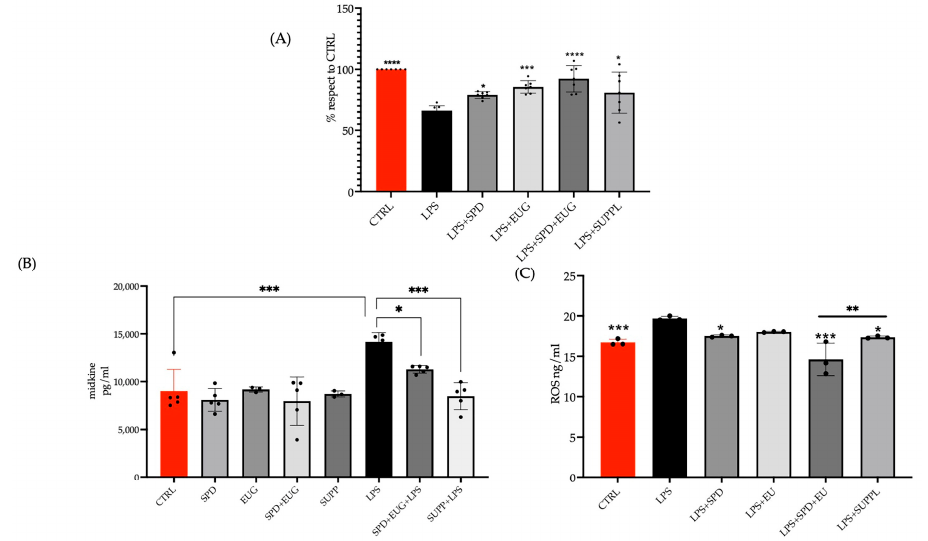
Figure 6. The effect of a pretreatment (1 h) of 1.2 µ M spermidine (SPD) and 0.2 mM eugenol (EUG) alone, in combination (1.2 µ M SPD + 0.2 mM EUG), and in supplement (SUPPL) form (1.2 µ M SPD + 92 µ M EUG) prior to the addition of 1 ng/mL lipopolysaccharide (LPS) for 24 h on ( A ) cell viability, ( B ) Midkine levels, and ( C ) ROS levels in NCM460 cells compared to the untreated control (CTRL) and LPS treatment alone. Significant differences were represented as follows: * 0.01 < p < 0.05, ** 0.001 < p < 0.01, *** 0.0001 < p < 0.001, **** p < 0.0001. The black dots indicate the positioning of the individual replicates within the bar for each sample.